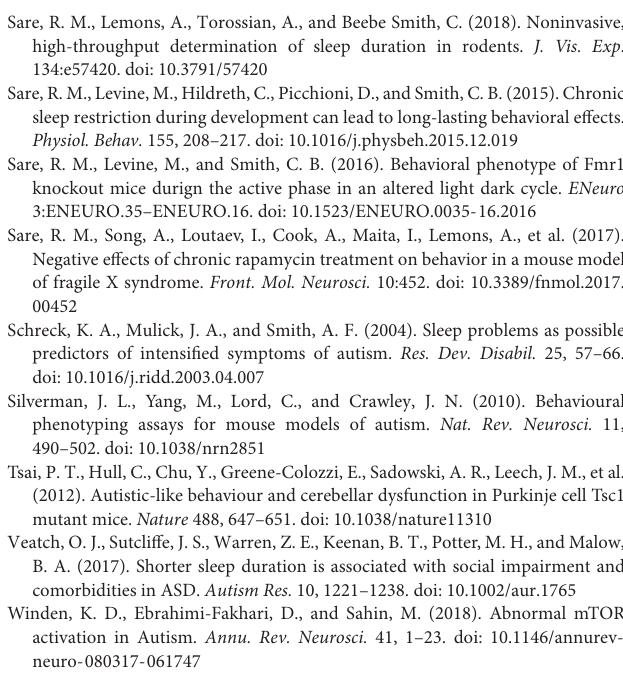
FIGURE S1 | Social behavior data showing time in all three chambers at P48 (A,C) and at P90 (B,D) after recovery. This data is a re-representation of Figures 7A,B , 8A,B also showing the time spent in the center chamber for (A,B) sociability and (C,D) social novelty. Mice traveled in all three chambers. Ear bar is the mean ± SEM for the number of mice indicated in